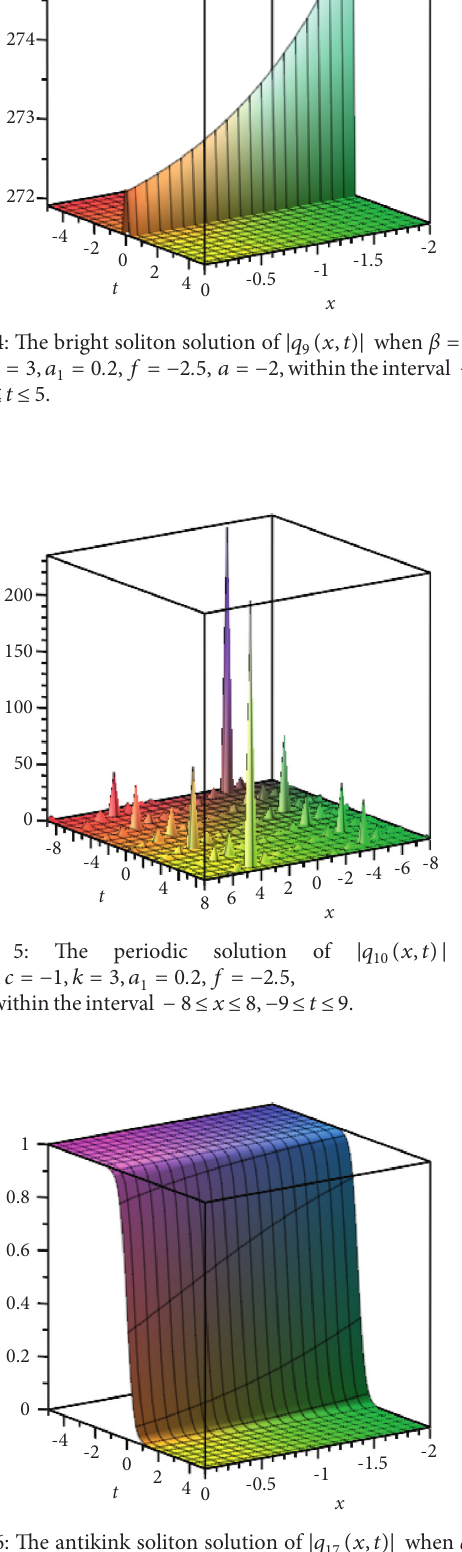
( x,t )| when a � 1 , 17 1